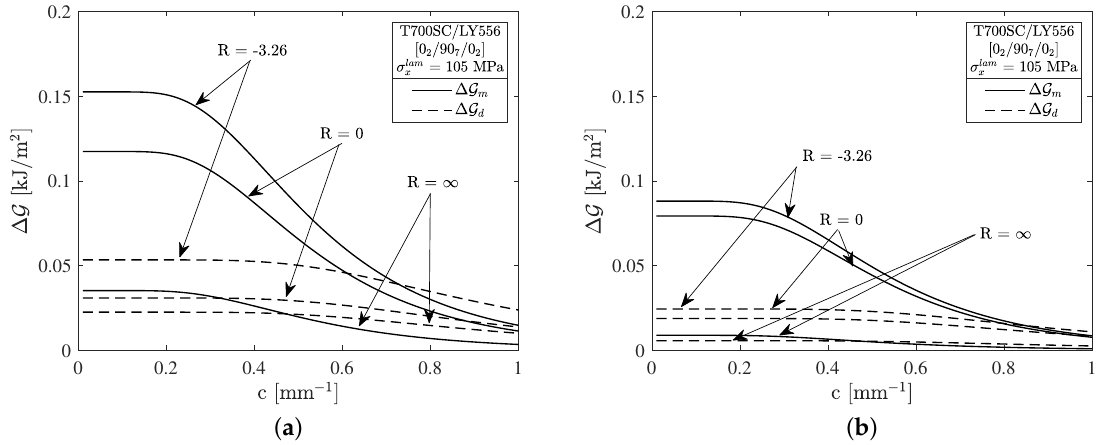
Figure 5. The strain energy release rate for the formation of a microcrack G m compared to the energy release rate for the initiation of a crack tip delamination G d for different load ratios and residual stresses within the = 25.7 MPa and ( b ) σ 90, res = 15.3 MPa, 90 ◦ -layer of magnitudes ( a ) σ 90, res 22 22